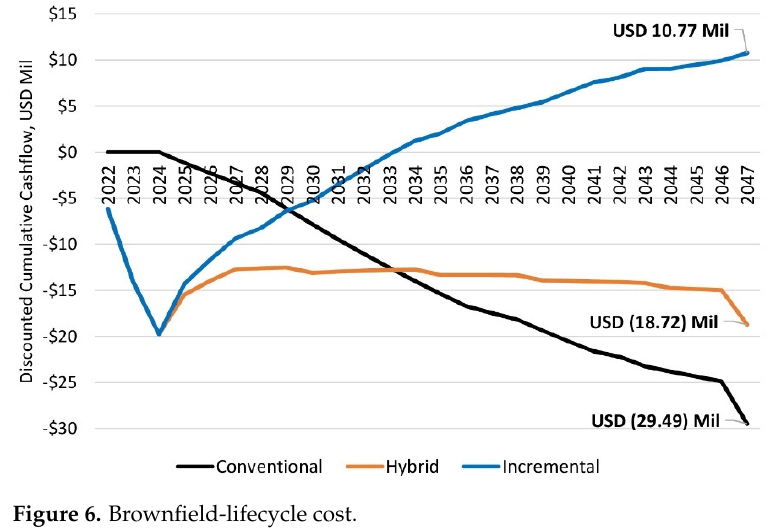
Table 4. Capital allowance.